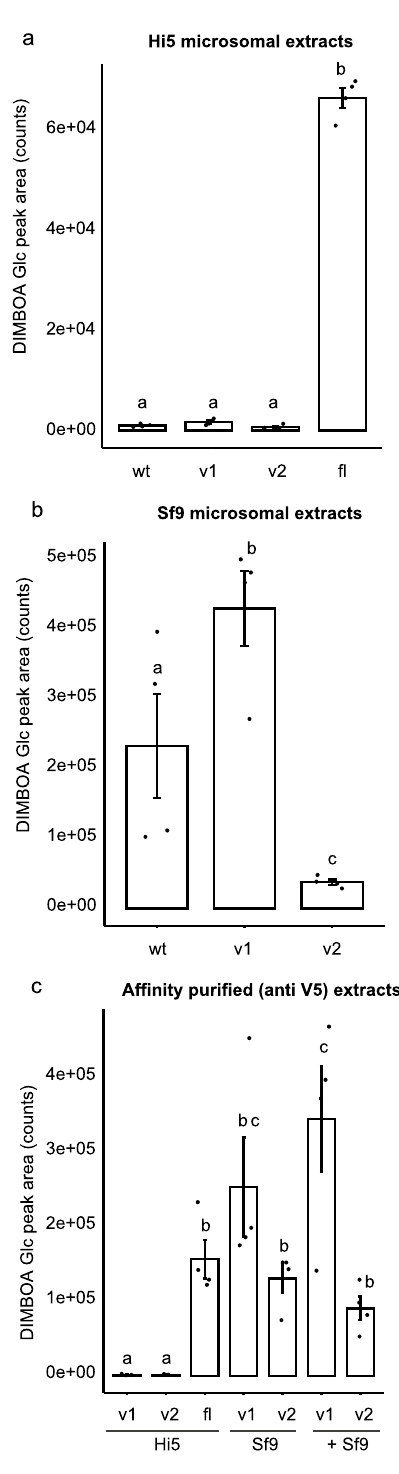
Figure 5. Truncated SfUGT33F28 variant proteins are catalytically inactive but may interact with the full- length UGT33F28 protein. ( a , b ) In vitro enzymatic assays with microsomes derived from Hi5 cells and Sf9 cells over-expressing SfUGT33F28 variants towards DIMBOA as substrate, ( c ) in vitro enzymatic assays with affinity-purified microsomes derived from Hi5 cells and Sf9 cells over-expressing SfUGT33F28 variants using DIMBOA as substrate. Data are represented as mean ± SEM (n = 4). One-way repeated measures ANOVA was performed and the Holm–Sidak method was applied to carry out all pairwise comparisons. Small letters on the bars indicate significant differences at P < 0.05. wt wildtype, v1 variant 1, v2 variant 2, fl